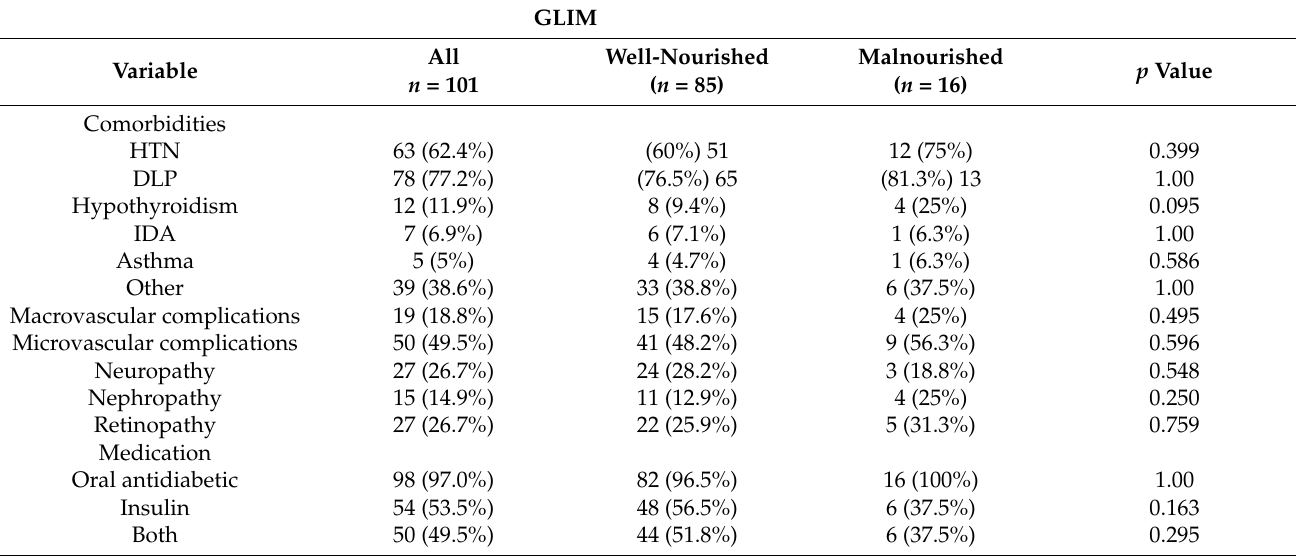
Table 3. Comorbidities, complications, and medication in patients with T2DM according to the GLIM.